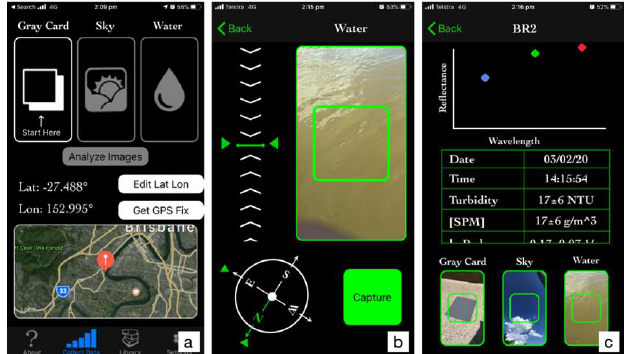
Figure 4. The three steps involved in capturing data on the Brisbane river with the HydroColor (HC) application. ( a ) The opening screen as ‘start here,’ suggesting the starting photo. The first photo is of a grey card, the second photo taken is of sky and the third photo is of the water (shown in b ). The results are summarized in ( c ).